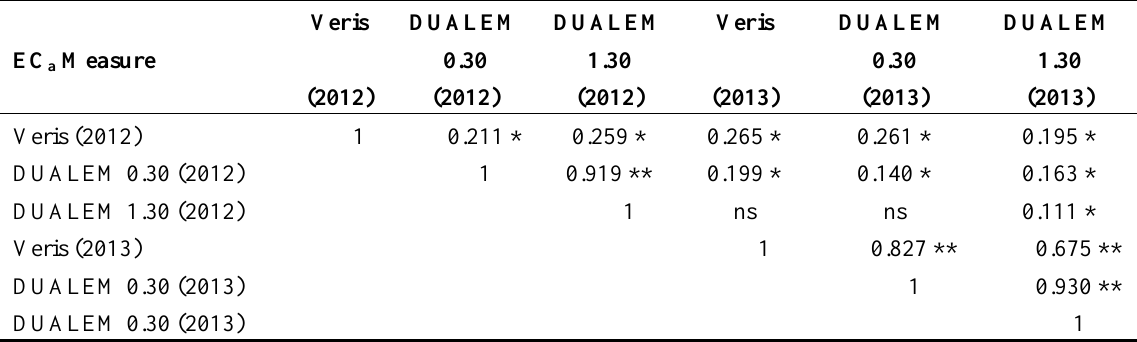
data measured by the two a